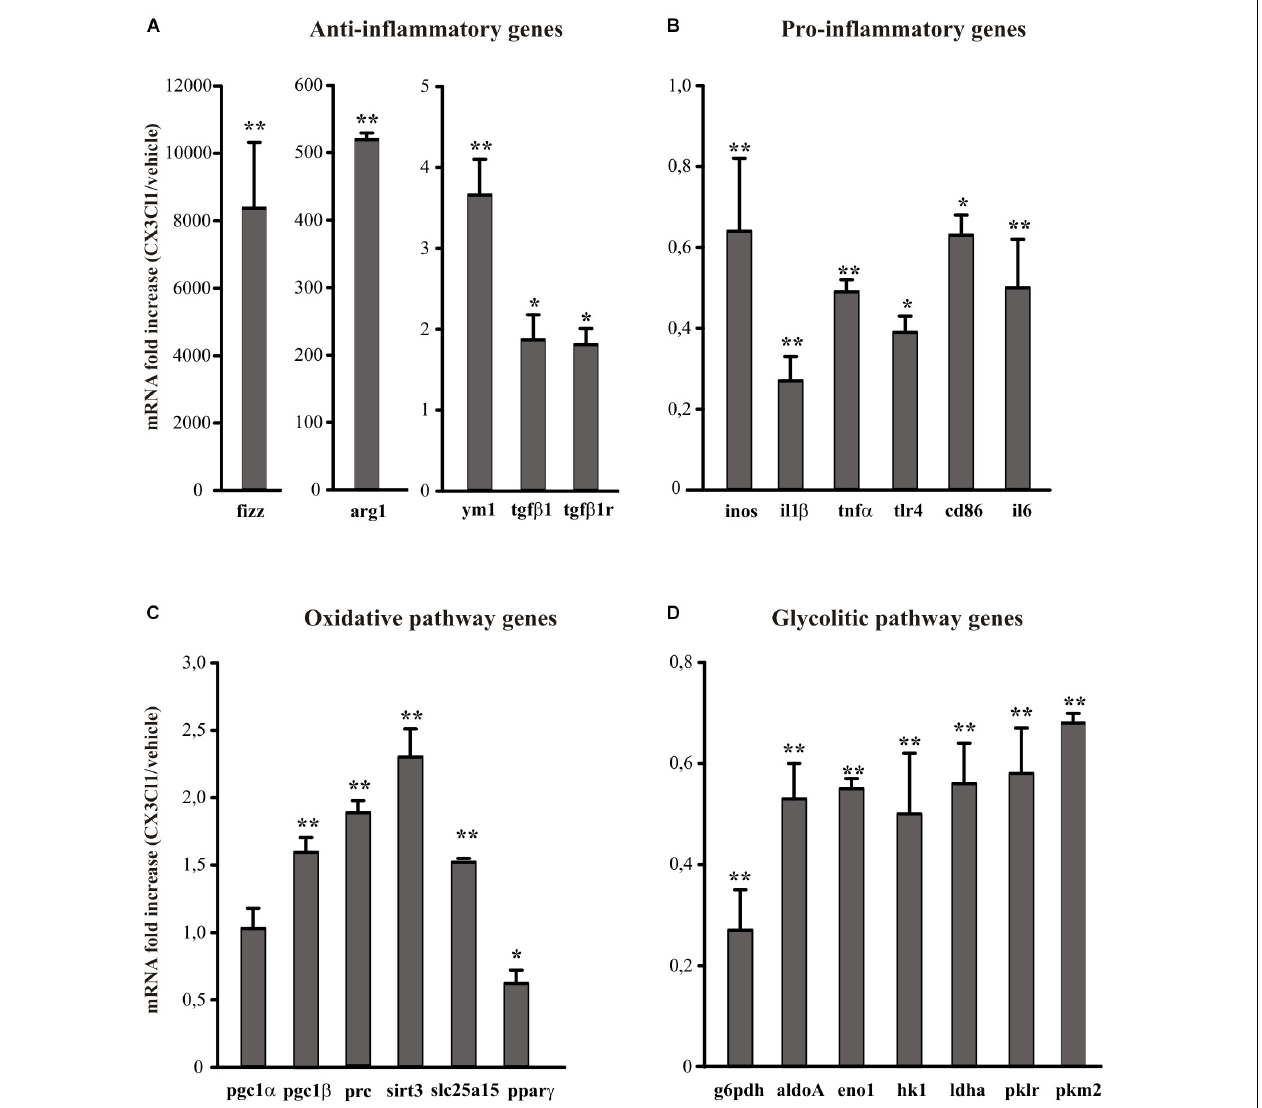
FIGURE 1 | Effects of CX3CL1 in modulating microglia polarization state. Expression analysis by RT-qPCR for mRNAs of anti-inflammatory ( A : arg1, ym1 , fizz, tgf β 1, tgf β 1r ), pro-inflammatory ( B : i nos, il1 β , tnf α , tlr4, cd86, il6 ) oxidative pathway ( C : pgc1 α , pgc1 β , prc , sirt3 , slc25a15 ppar γ ) and glycolytic pathway ( D : g6pdh, aldoA, eno1, hk1, ldh α , pklr, pkm2 ) related genes in primary wt microglia treated with CX3CL1 (100 nm, 24 h). For each gene data are expressed as specific mRNA fold increase in CX3CL1 treated cells normalized to specific mRNA expression in vehicle. Statistical analysis: Data are expressed as the mean ( ± SEM.) of n = 8, ∗∗ p < 0.001, ∗ p < 0.05, Student’s t-